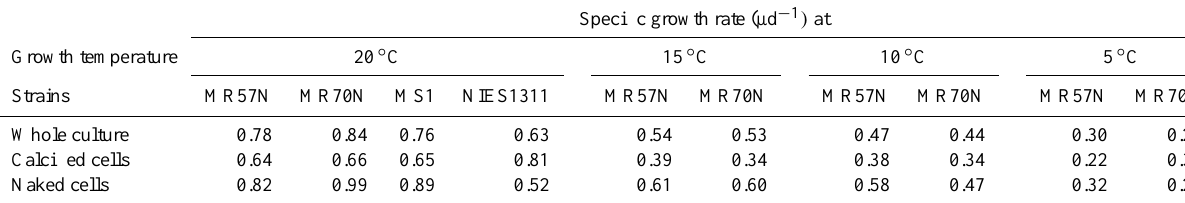
Table 1. Temperature effect on specific growth rates ( µ) of various strains of the coccolithophore E. huxleyi isolated from the Bering Sea (MR57N), the Arctic Sea (MR70N), the North Sea (MS1), and the Bering Sea (NIES1311). In the whole culture, numbers of calcified cells with coccoliths and naked cells without coccolith were separately counted under microscope. Salinity of the medium was 32‰. All values are average of three separate experiments ( n = 3).